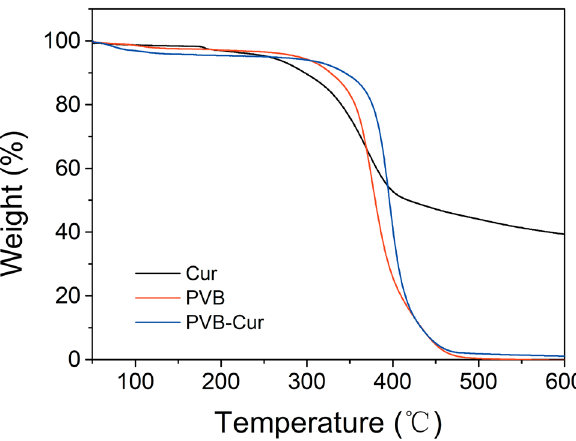
Figure 4: Thermal stability of PVB, Cur, and PVB – Cur fi